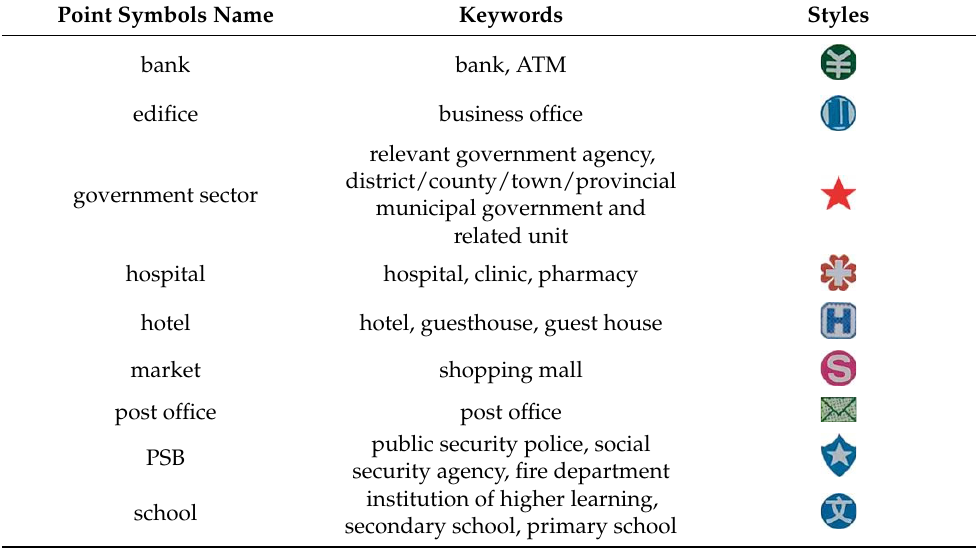
Table 5. Keywords and symbols styles associated with point symbols.